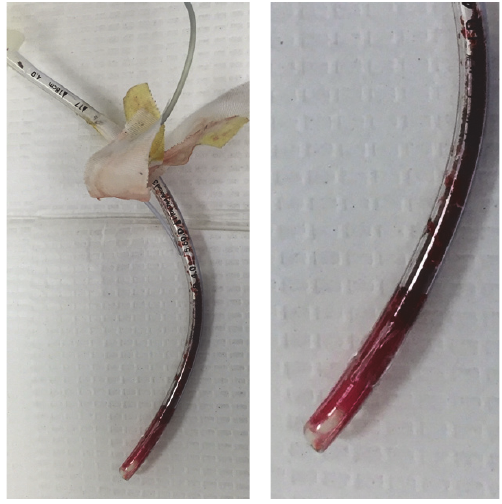
Figure 2: Blood impacted endotracheal